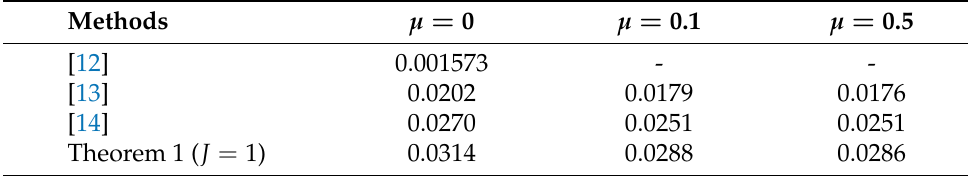
Table 1. Delay bound h ∗ calculated for Example